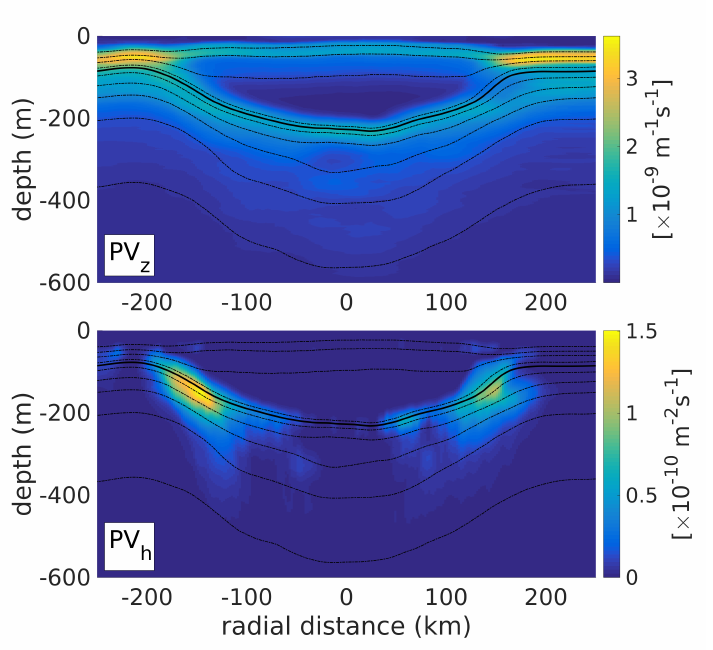
Figure 12. Vertical ( upper panel) and baroclinic ( lower panel) terms of Ertel’s potential vorticity (Equation